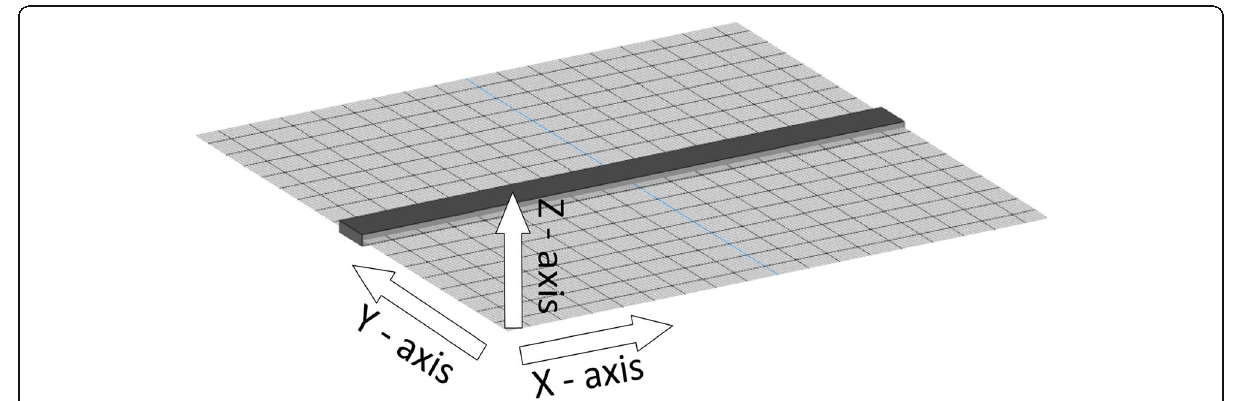
Fig. 2 Build Orientation for Mechanical Test